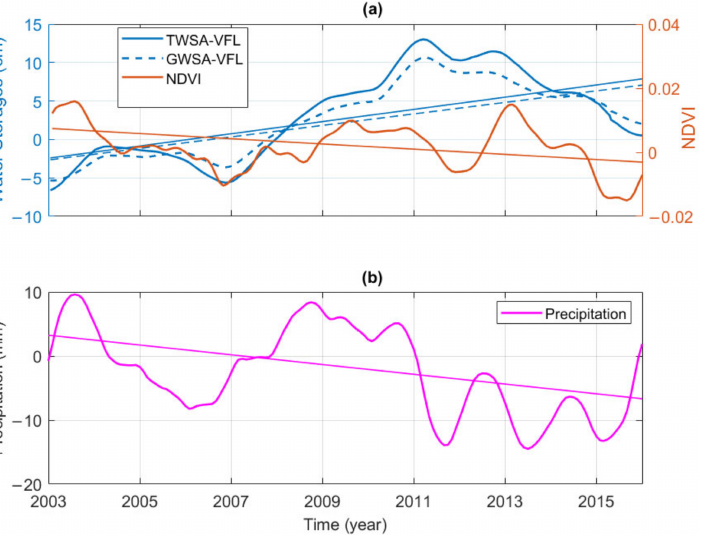
Figure 14. Monthly long-term variations of ( a ) water storage from TWSA VFL (blue curve) and GWSA VFL (dashed blue curve), and NDVI (red curve); ( b ) precipitation from 2003 to 2016. The long-term (linear + interannual) components were obtained using the STL method. Derived linear Trends using least square fitting approach are presented as line or dashed